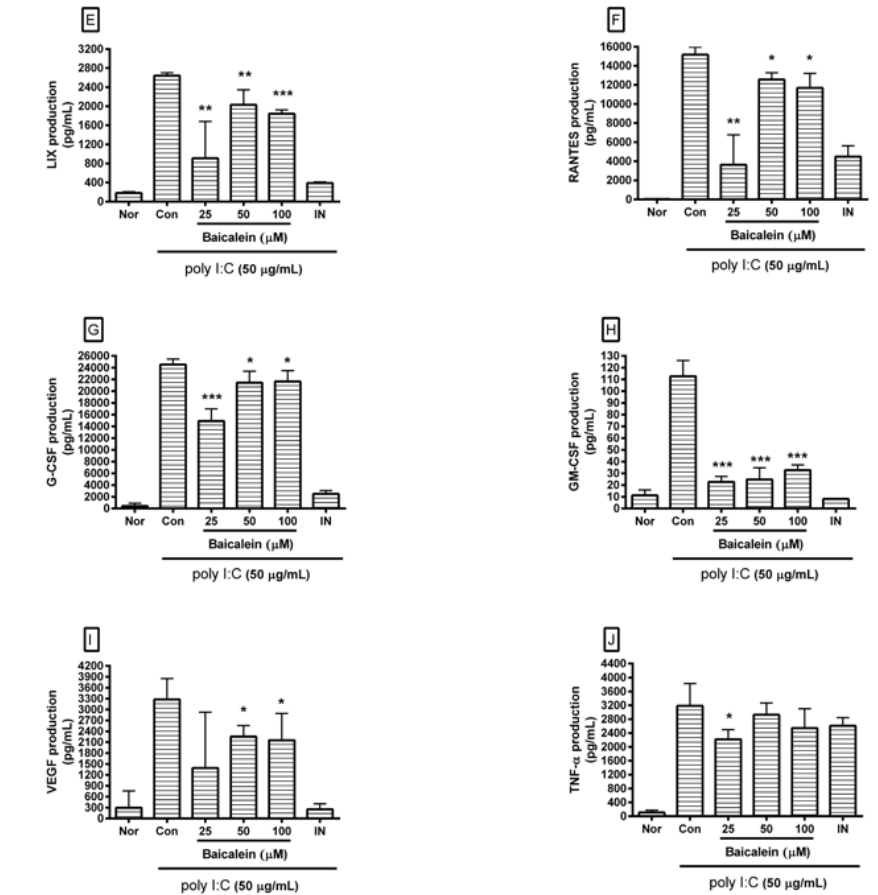
Figure 3. Effect of baicalein on production of cytokines such as monocyte chemotactic protein (MCP)-1 ( A ); interleukin (IL)-6 ( B ); IL-1α ( C ); interferon-inducible protein (IP)-10 ( D ); lipopolysaccharide-induced CXC chemokine (LIX; CXCL5) ( E ); Chemokine ligand 5 (CCL5; RANTES) ( F ); granulocyte colony-stimulating factor (G-CSF) ( G ); granulocyte macrophage colony-stimulating factor (GM-CSF) ( H ); vascular endothelial growth factor (VEGF) ( I ); and tumor necrosis factor-alpha (TNF- α ) ( J ) by RAW 264.7 cells induced by poly I:C. Nor was treated with media only. Con was treated with poly I:C (50 µ g/mL) alone. IN: indomethacin (0.5 µ M). Values are mean ± SD. * p < 0.05 vs. Con; ** p < 0.01; *** p < 0.001.